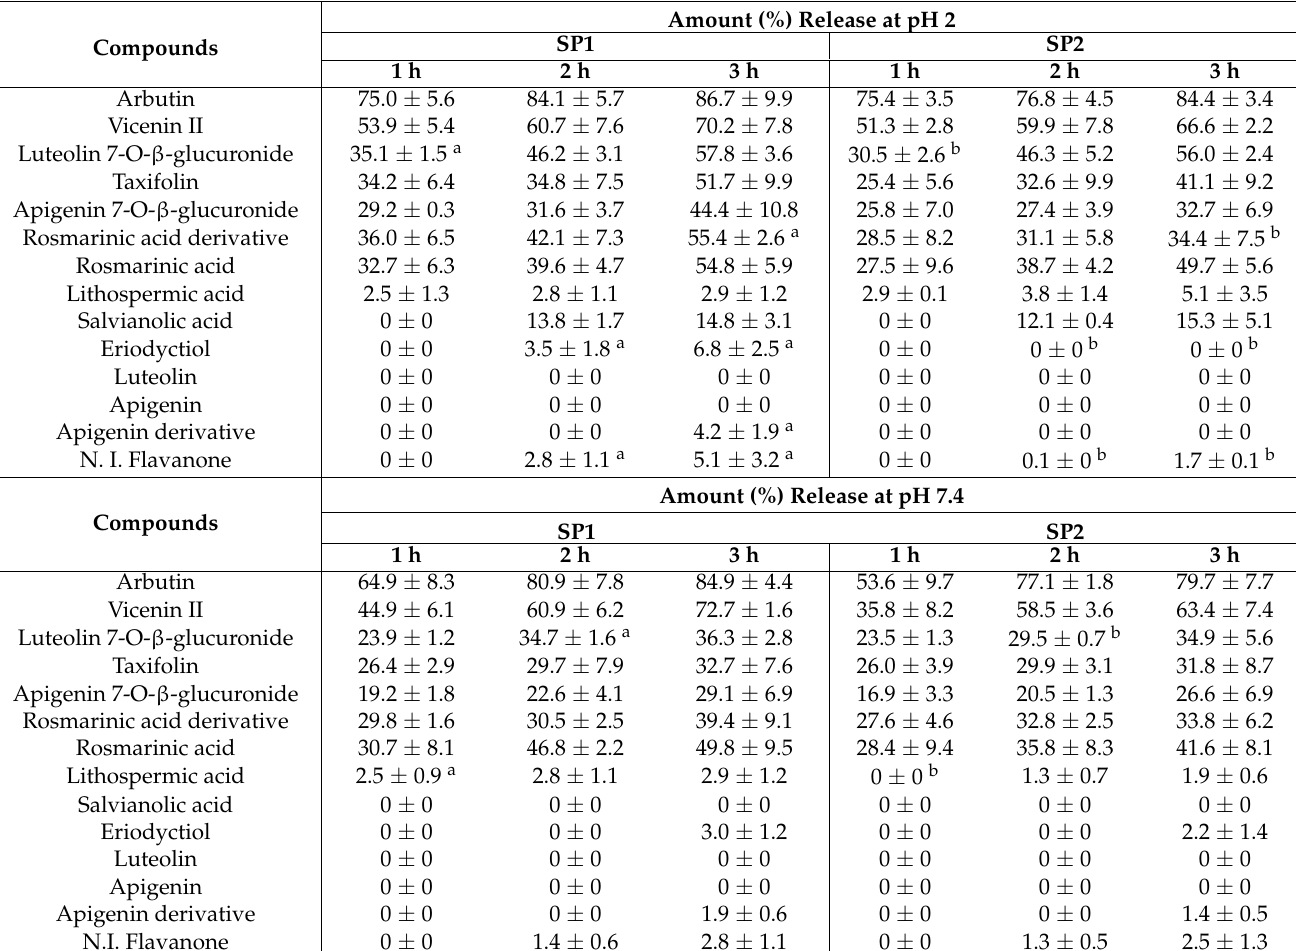
Table 5. Amount (%) of phenolic compounds released after 1, 2, and 3 h from SP1 and SP2 formula- tions at pH 2 and pH 7.4 (mean ± SD, n =